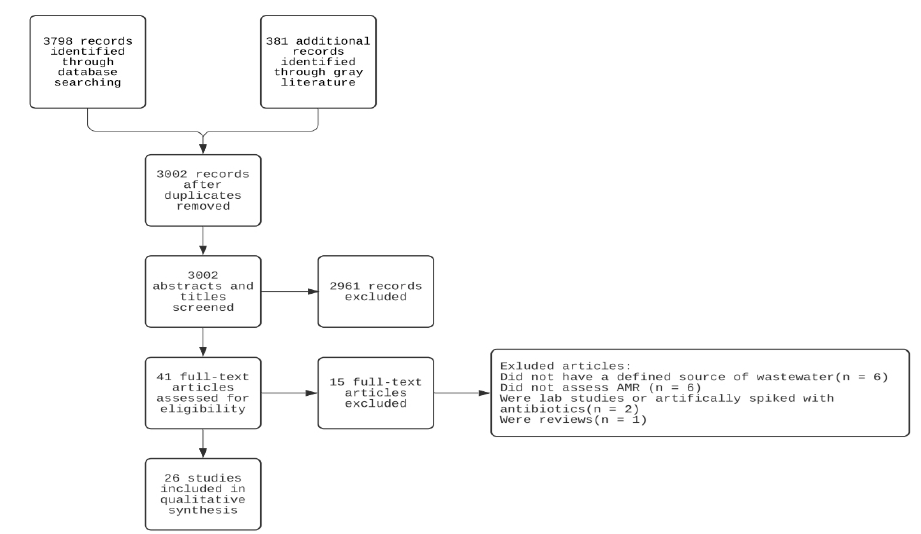
Figure 2. Flowchart of literature review and screening.